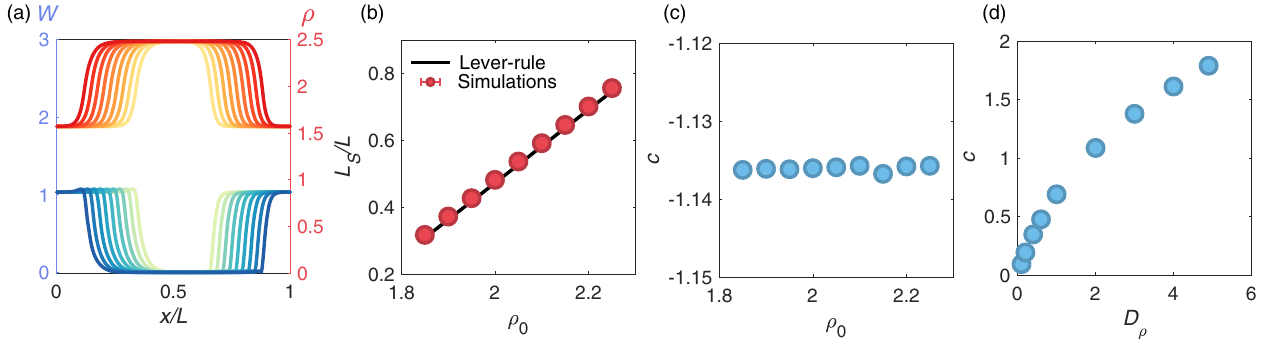
FIG. 5. Shape and dynamics of active-solid jams. (a) Density and velocity profiles computed for different value of ρ 0 : from 1.85 (light colors) to 2.25 (dark colors). Numerical resolution of Eqs. (1) and (2) with the hydrodynamic parameters D ρ ¼ 5 , D 0 . 5 , L ¼ 200 , dx ¼ 0 . 01 , dt ¼ 0 . 001 . (b) Length of the solid jam plotted versus ρ a 4 ¼ 1 , σ ¼ 1 , ¯ ρ ¼ 2 , ξ ¼ 0 . 1 , α ¼ 1 , ρ c ¼ (symbols) and lever rule (solid line). Same parameters as in (a). (c) The speed of the solid jam c does not depend on the average density ρ 0 . (d) Variations of the propagation speed c as a function of the effective diffusivity D ρ . Numerical parameters are D W ¼